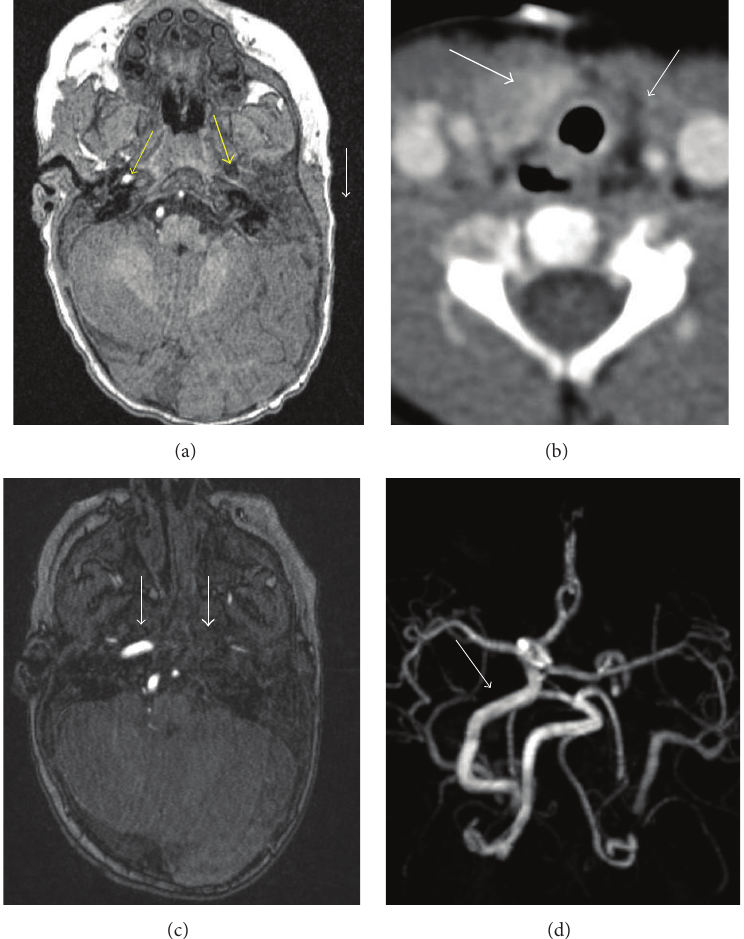
Figure 2: (a) Axial T1 weighted MR of the brain without contrast through the level of the external auditory canals demonstrates absence of the left external ear and external auditory canal (thin white arrow). There is also absence of the left internal carotid artery (thick yellow arrow). The right internal carotid artery is shown for comparison (thin yellow arrow). (b) Axial postcontrast CT of the neck at the level of the thyroid gland shows a normal right thyroid lobe (thick white arrow) with absence of the left thyroid lobe (thin white arrow). (c) Axial noncontrast time of flight MRA of the brain demonstrates a normal right internal carotid artery at its petrous segment (thin white arrow). There is absence of the left internal carotid artery (thick white arrow). (d) Three-dimensional reformation of the MRA of the brain demonstrates a normal right internal carotid artery (thin white arrow). The left internal carotid artery is